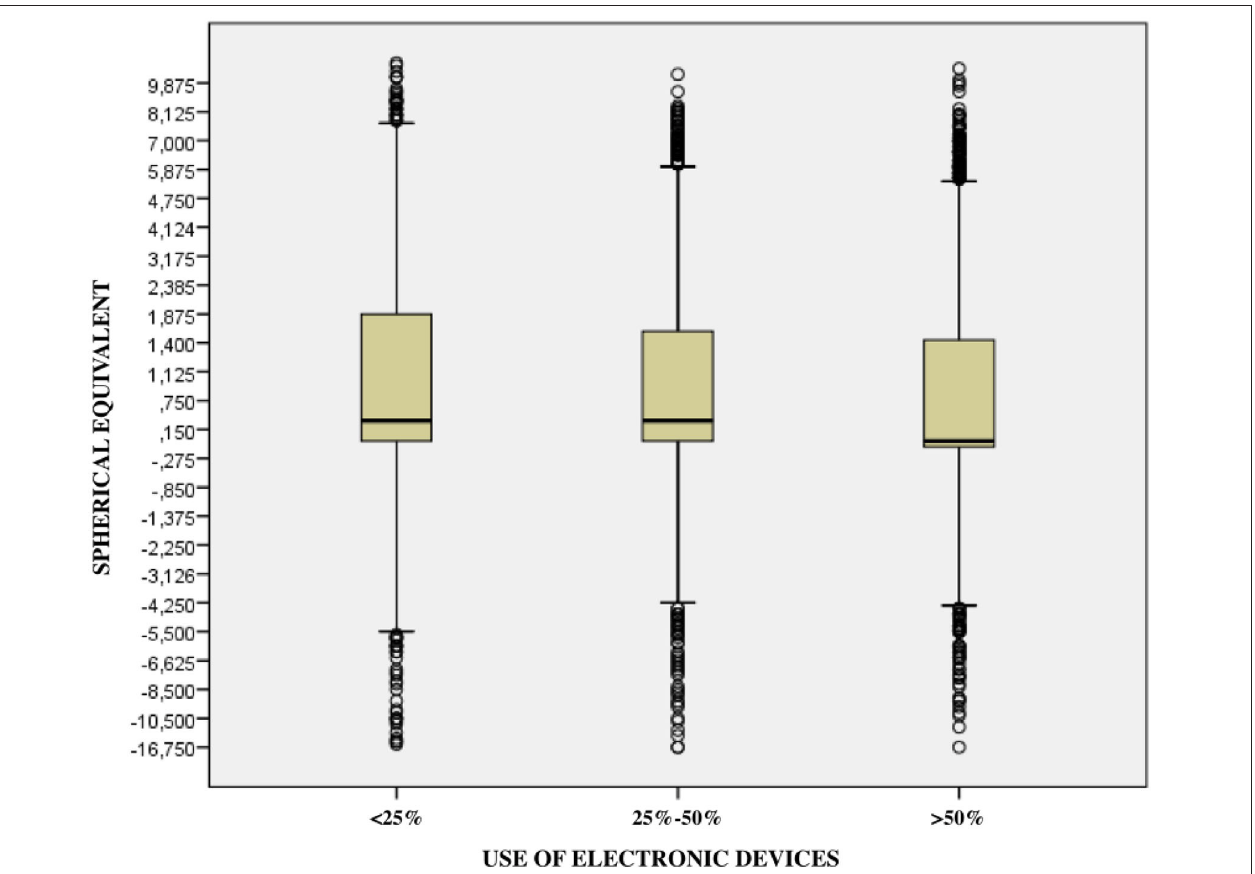
FIGURE 3 | Relationship between the use of digital devices and the magnitude of refractive